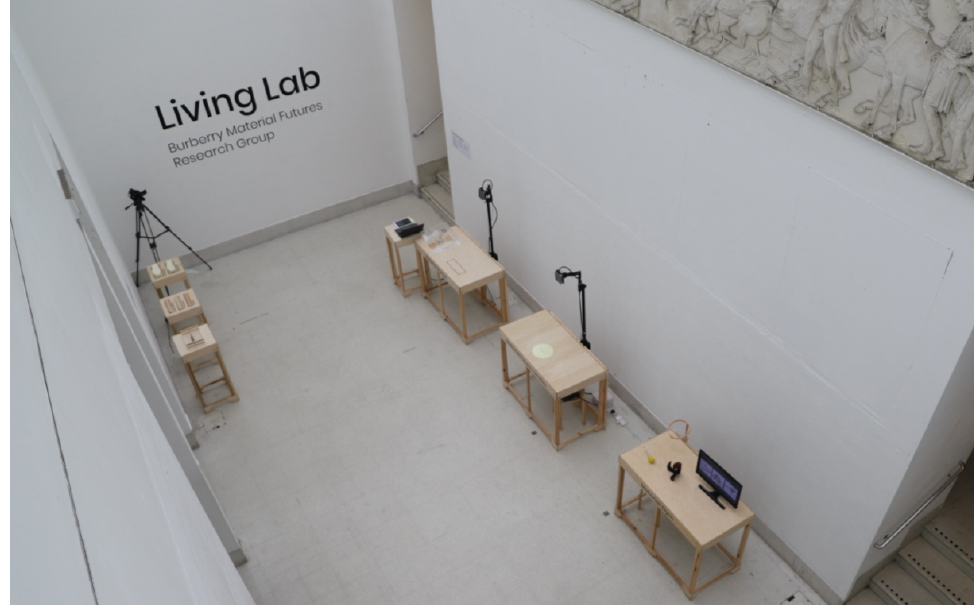
Figure 9. The journey of the Compositor